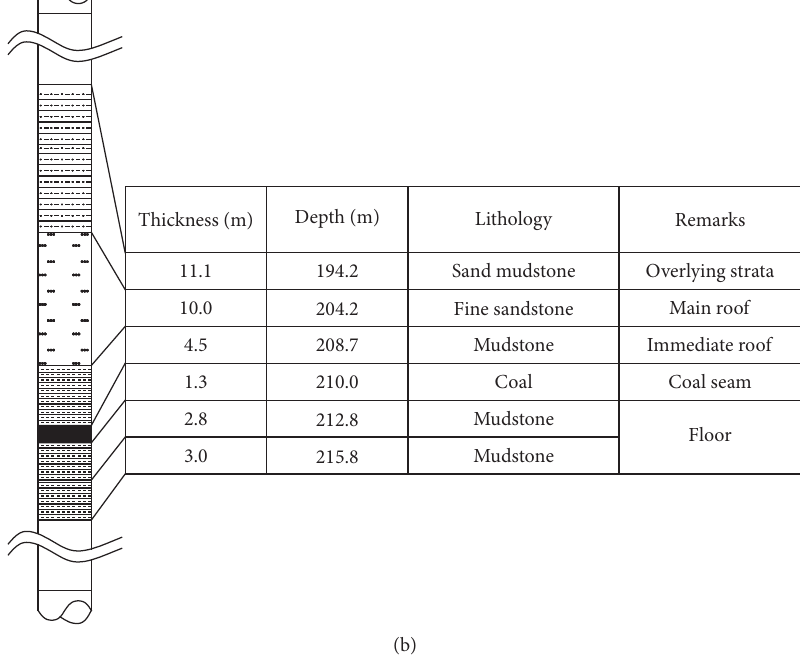
Figure 6: Geological conditions of production at the #1103 working face in Heilong Coal Mine. (a) Mining plan of the #1103 working face. (b) Comprehensive column chart of the coal seam and roof and floor of the #1103 working